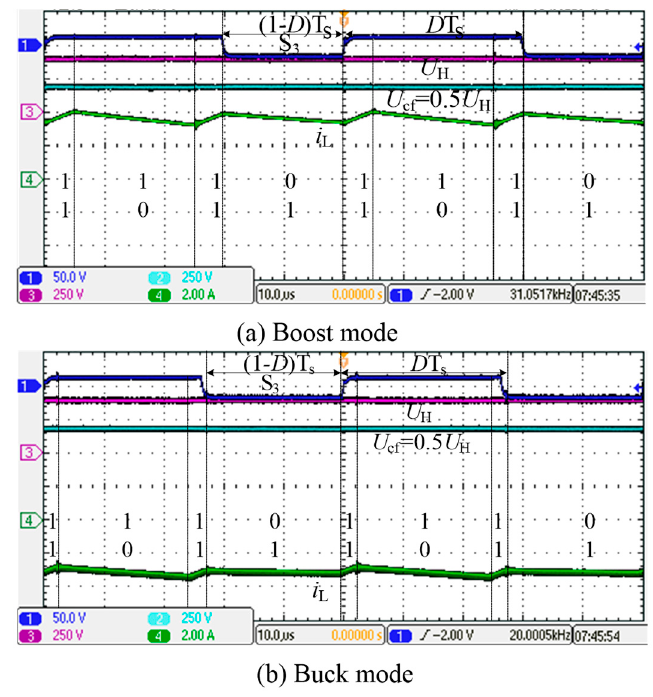
Figure 6. Experimental verification of the fly capacitor TL-BDC.